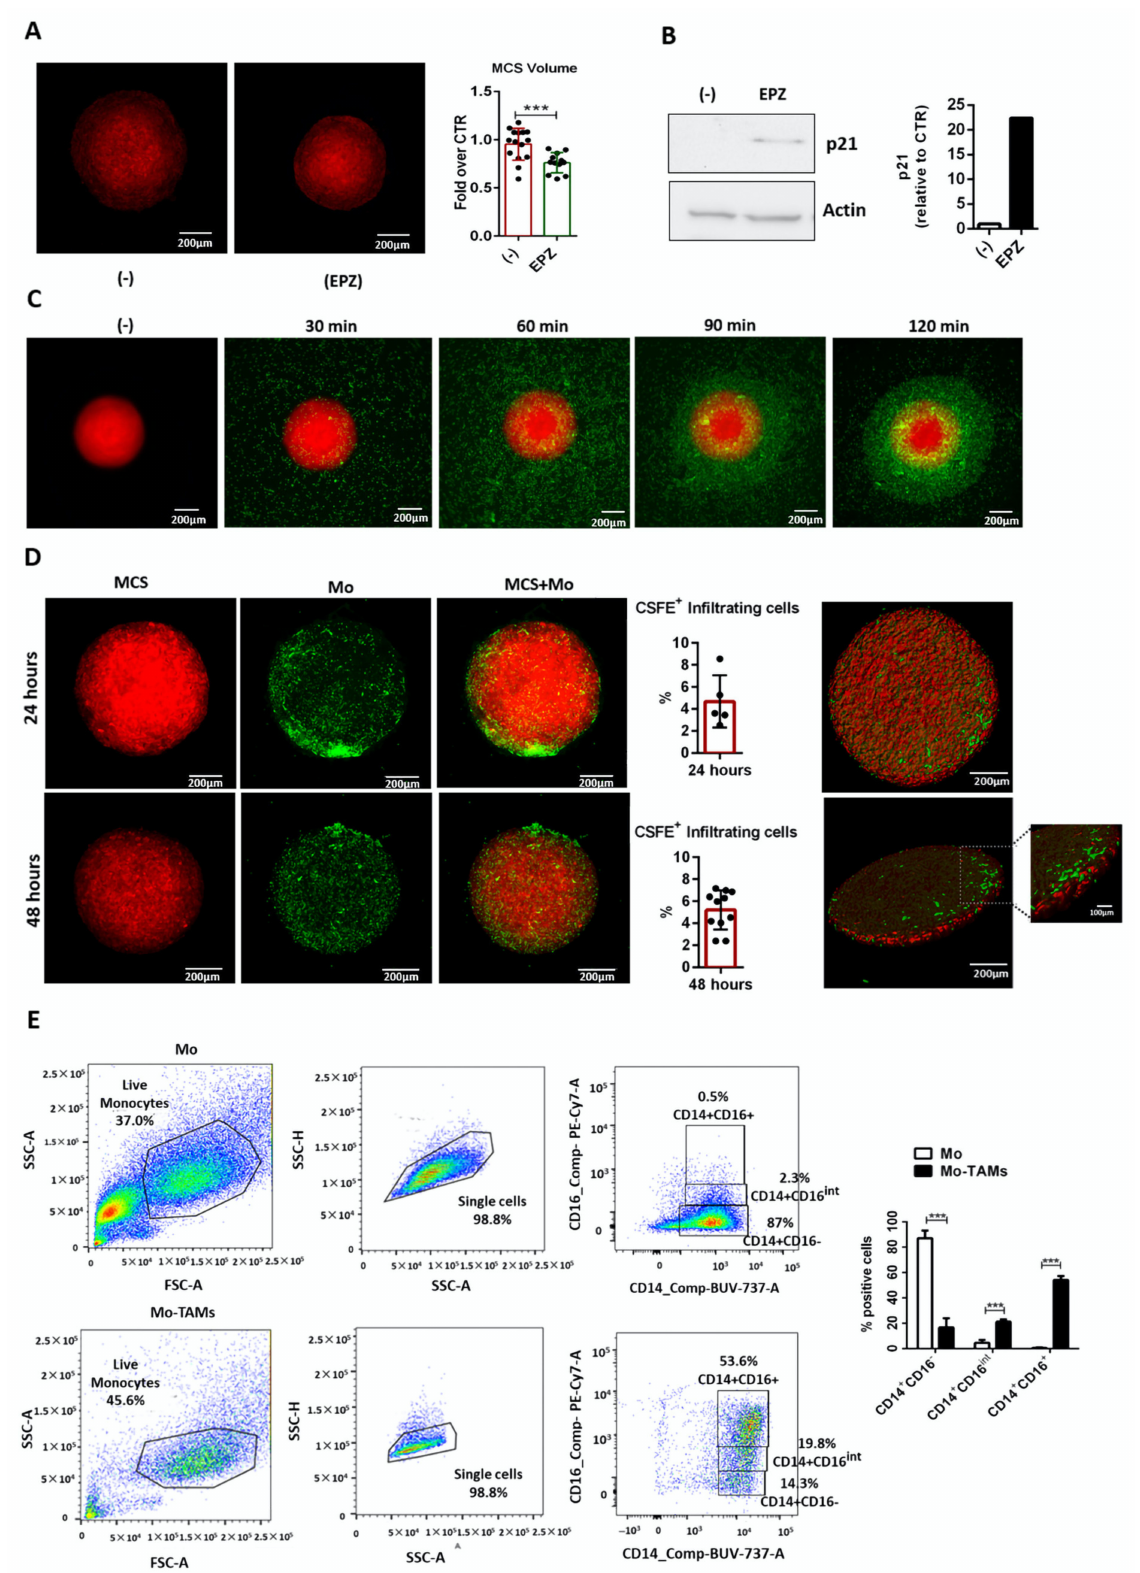
Figure 1. Human monocytes infiltrate MPM MCS ( A ) Volume of mCherry-MSTO-211H MCS treated with EPZ-6438 (EPZ, 10 µ M) or vehicle (-) for 96 h was evaluated by confocal microscopy and calculated by ImageJ-win64 software. The results are shown as fold over and vehicle treated MCS (-). Data are shown as mean ± SD *** p < 0.001 by two-tailed t -test, (-) N =